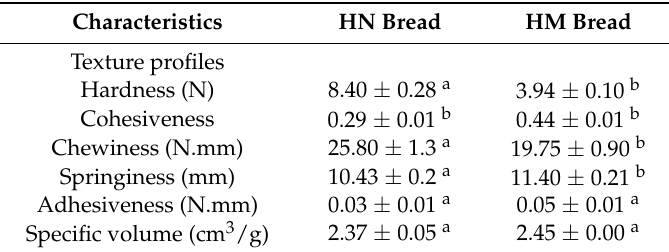
Table 3. Texture profile and specific volume of gluten free bread from Hom Nil rice flour (HN) and Hom Mali 105 rice flour (HM).